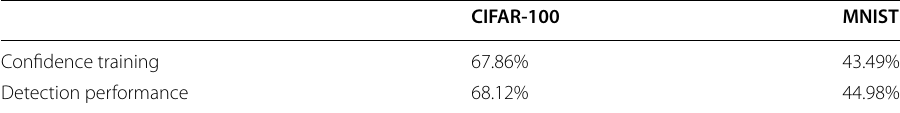
Table 2 Learning Scheme Effects